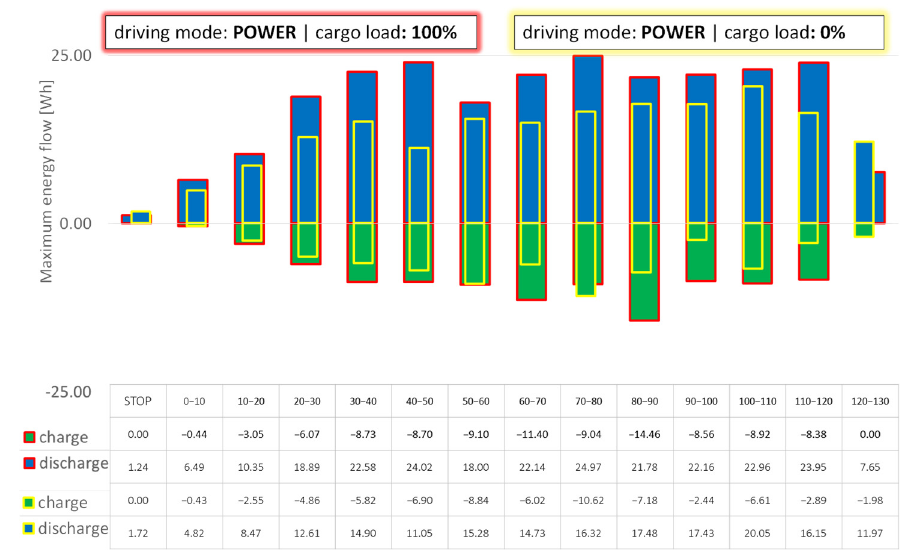
Figure 21. Maximum values of energy flow in speed intervals steps of 10 km/h.